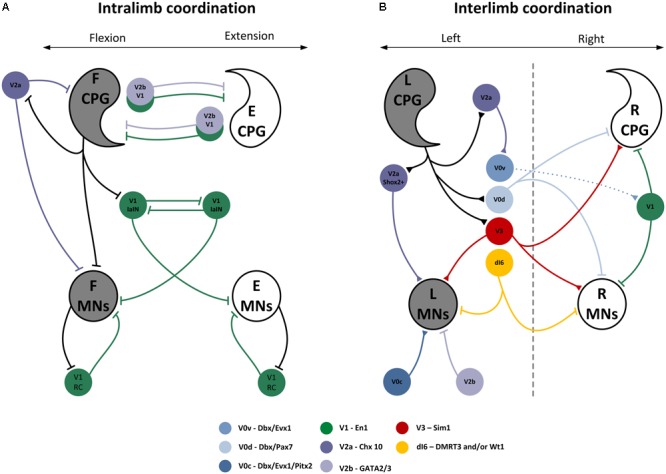
Genetically identified interneurons contributing to locomotion. Schematic of the synaptic connectivity of genetically identified populations of interneurons developing from the ventral spinal cord and involved in (A) intralimb and (B) interlimb coordination during locomotion. Experimentally demonstrated projections are illustrated by a solid line and predicted connectivity with a dashed line. Figure was developed based on Kiehn (2011, 2016) and Gosgnach et al. (2017).